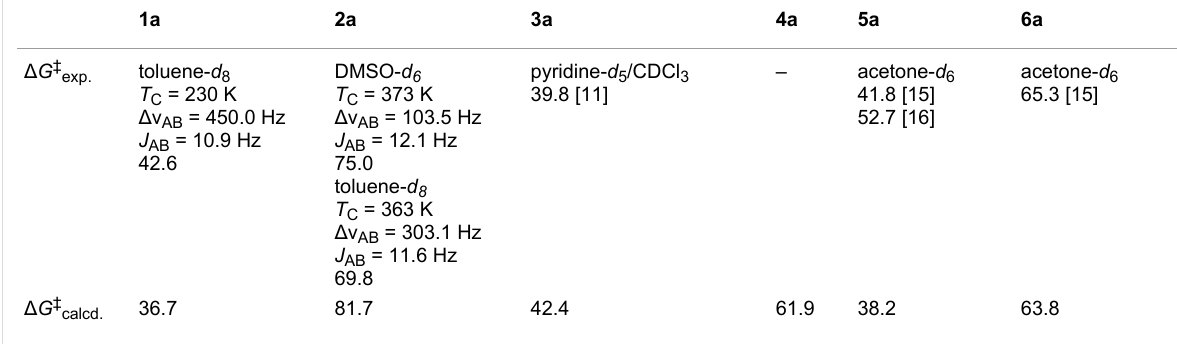
Table 4: Experimental al calculated inversion barriers (kJ mol –1 ).